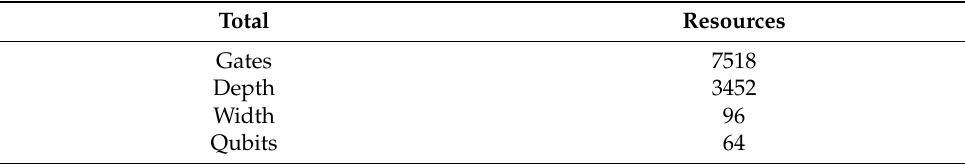
Table 6. Quantum resource estimation per